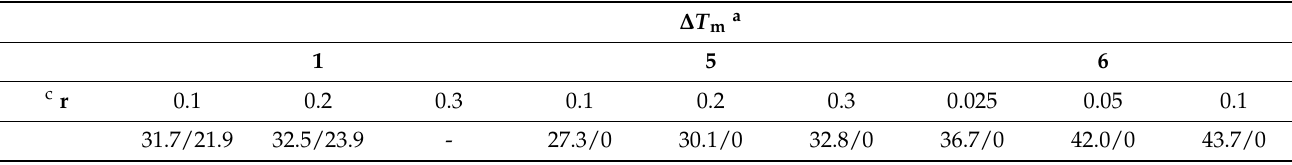
Table 4. The ∆ T m a values ( ◦ C) of ATT triplex b upon addition of ratio c r = [compound]/[polynucleotide] of 1 , 5 , and 6 d